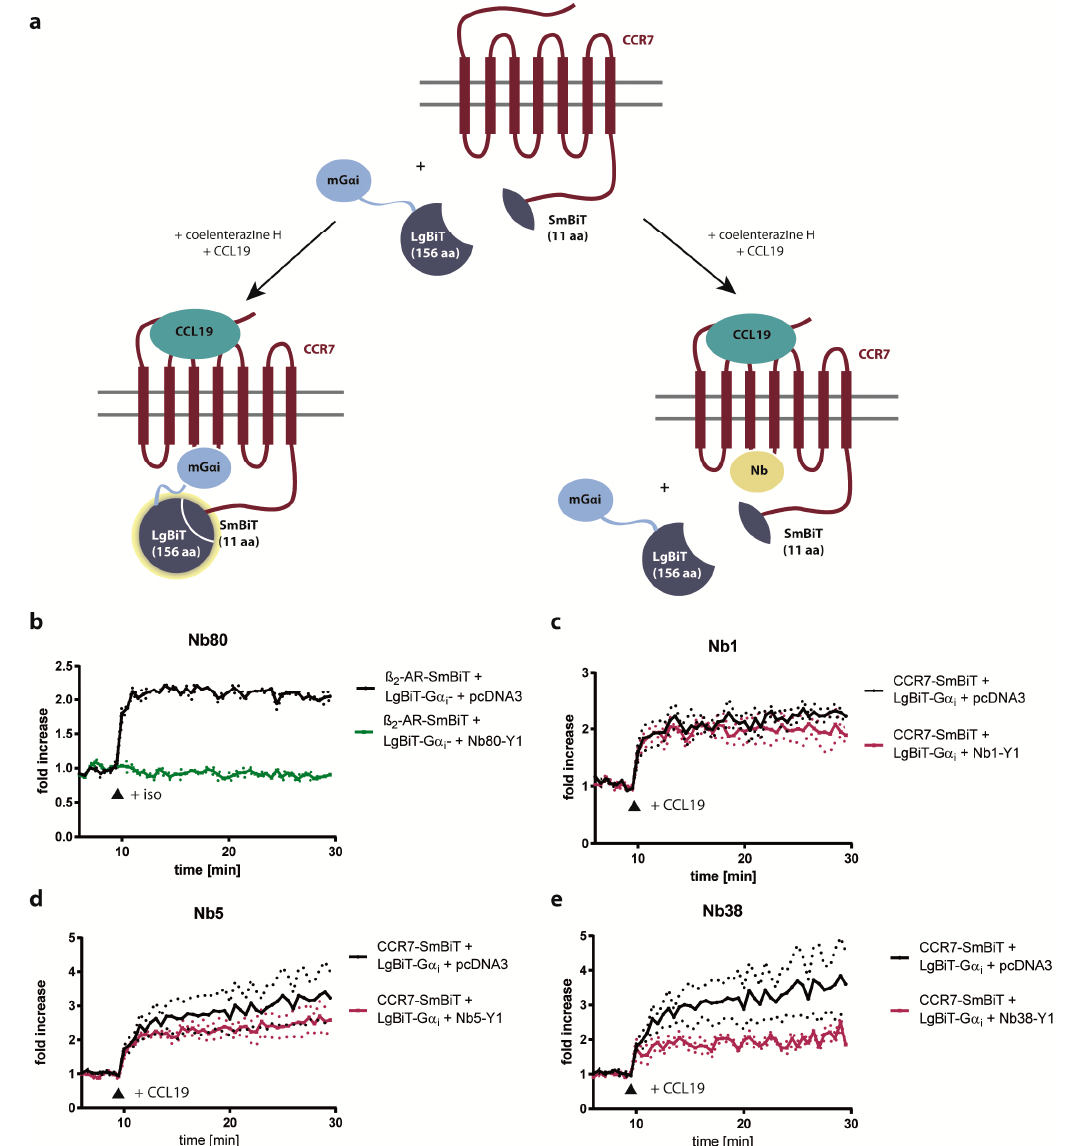
Figure 4. CCL19-triggered G-protein coupling to CCR7 is barely impaired by Nb1, Nb5, or Nb38. ( a ) Schematic illustration of the G-protein competition assay based on split-luciferase complementation. ( b – e ) HEK293 cells transiently expressing β 2 AR-SmBiT ( b ) or CCR7-SmBiT ( c – e ) together with LgBiT-mG α i and Nb-YFP1 (Nb-Y1) constructs were incubated with coelenterazine H (5 µM) and